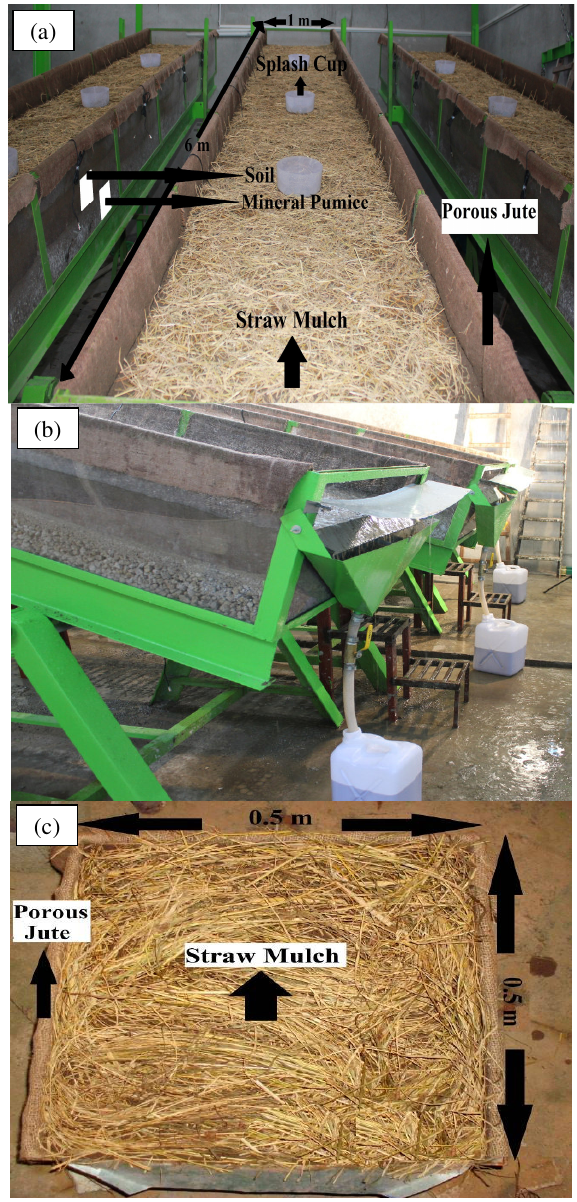
Figure 1. A general view of the treated plots of 6m 2 (a) , the runoff collection system at a 6m 2 plot outlet (b) and 0.25m 2 (c) with rice straw mulch under lab